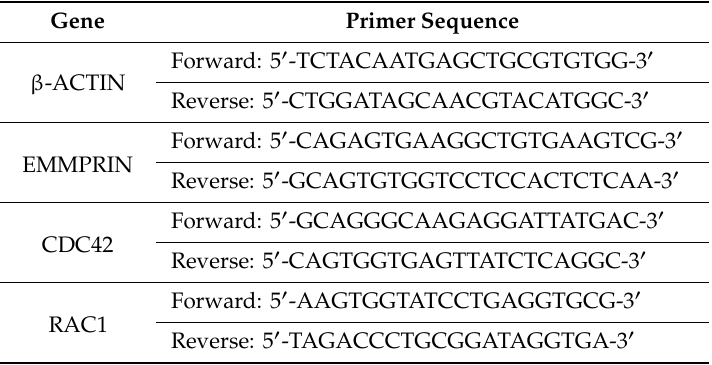
Table 1. Sequence of primer used for